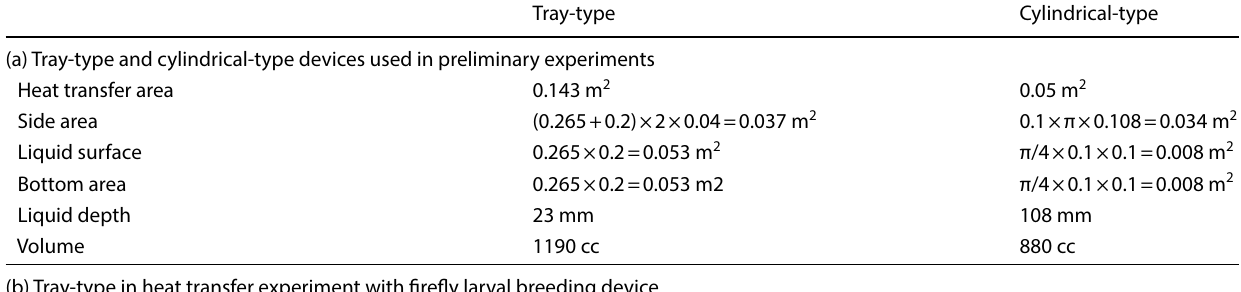
Table 1 Specifications of experiment devices